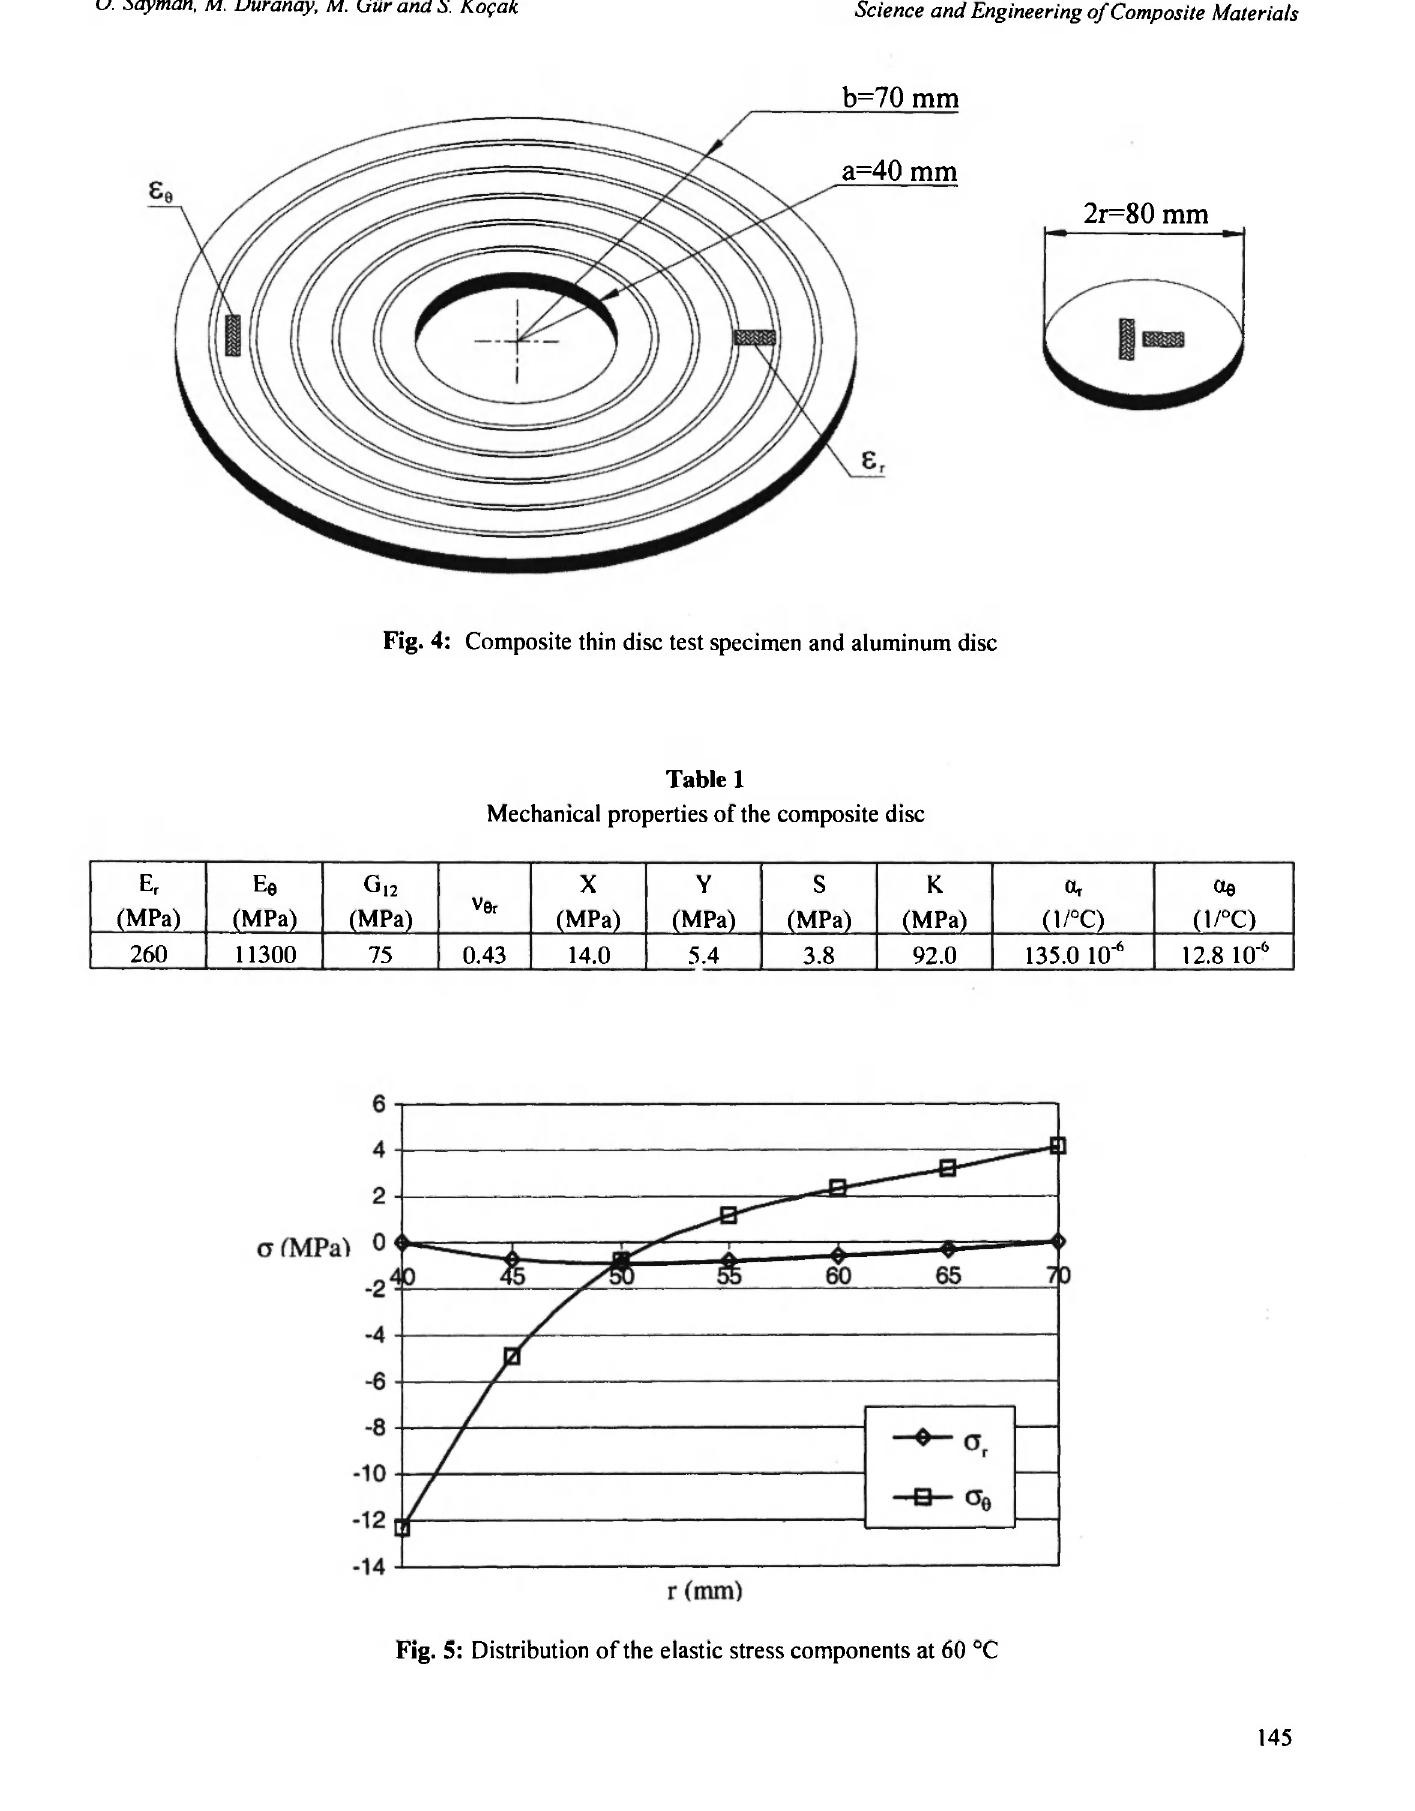
Fig. 5: Distribution of the elastic stress components at 60